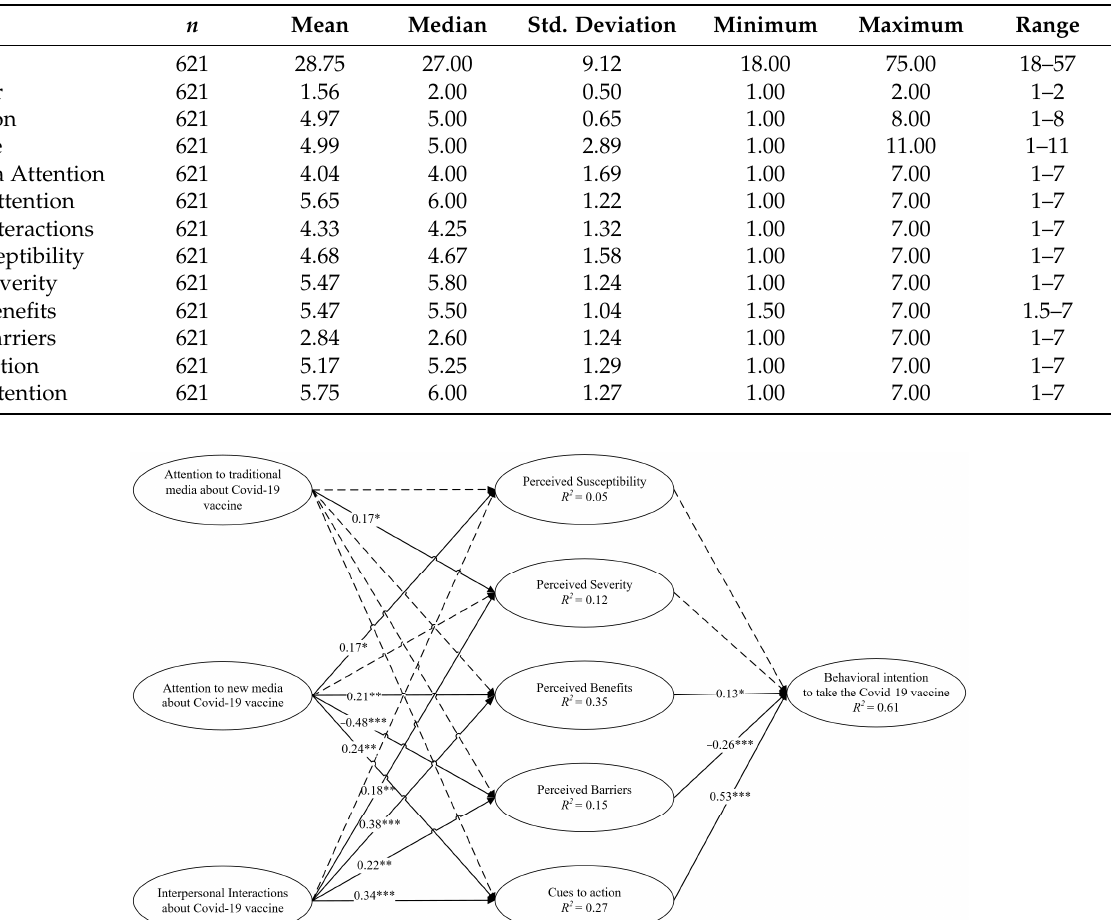
Table 1. Summary of the statistics of all variables ( n = 621).